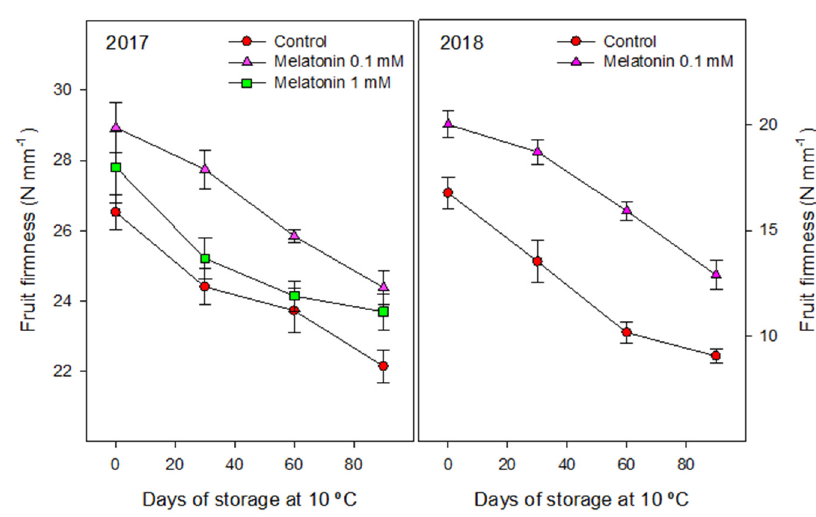
Figure 2. Fruit firmness evolution (Nmm − 1 ) during refrigerated storage in two consecutive production cycles (2017 and 2018), in control fruit and 0.1 or 1mM melatonin-treated trees. Data are the mean ± SE.